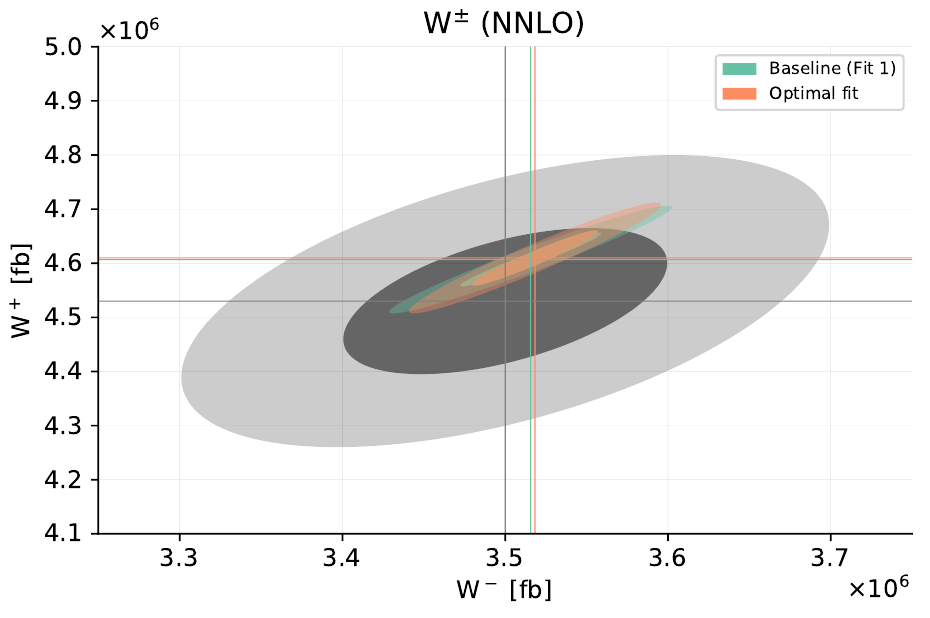
Figure 15 . Theoretical predictions for the W + and W (cid:0) cross section at NNLO obtained with the Baseline (cid:12)t (green) and the Optimal (cid:12)t (orange), compared to the 13 TeV measurement performed by ATLAS [122]. The 68% CL and 90% CL ellipses for the theoretical predictions are represented in dark and light shades, respectively. Correspondingly, the same CLs are plotted for the experimental measurement in dark and light